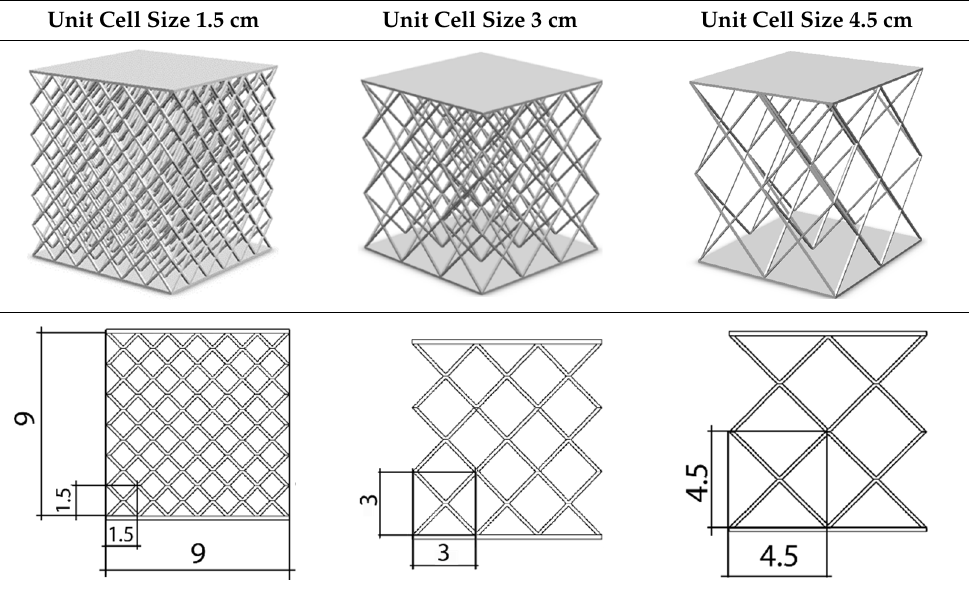
Table 1. Unit cell size dimensions (cm)—FCC structure example.